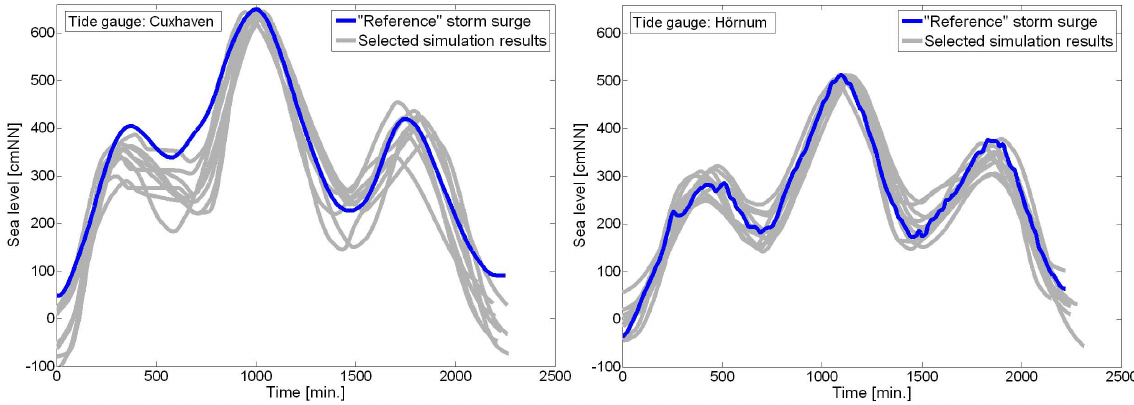
Fig. 12. Comparison of selected simulated storm surges with “reference” storm surges from former studies (left: Cuxhaven; right: